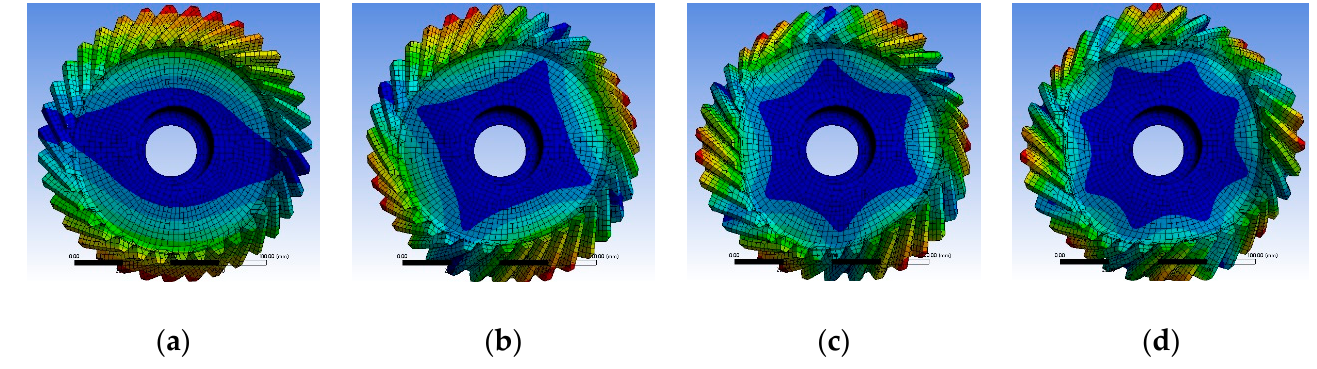
Figure 13. Vibration mode of bevel driven gear: ( a ) 1st; ( b ) 2nd; ( c ) 3rd; ( d ) 4th.